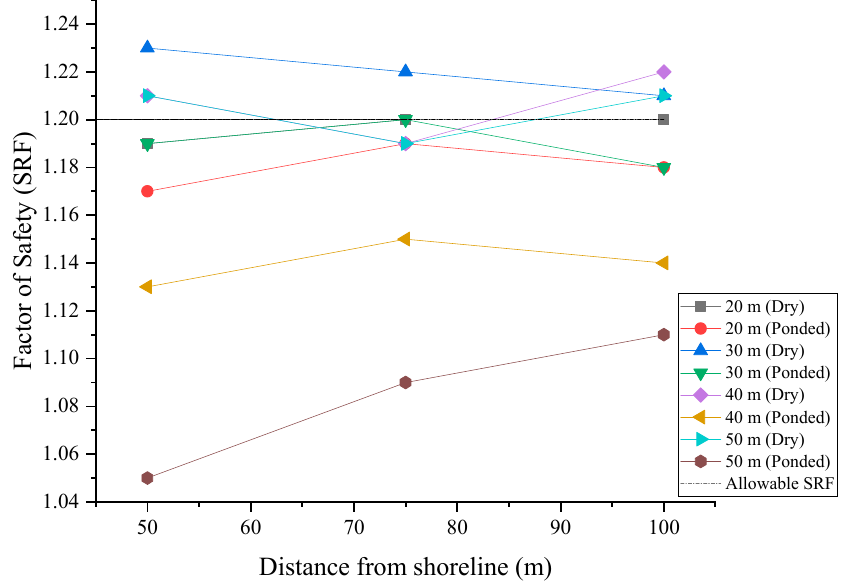
Figure 16. Variation in safety factor with distance from shoreline.